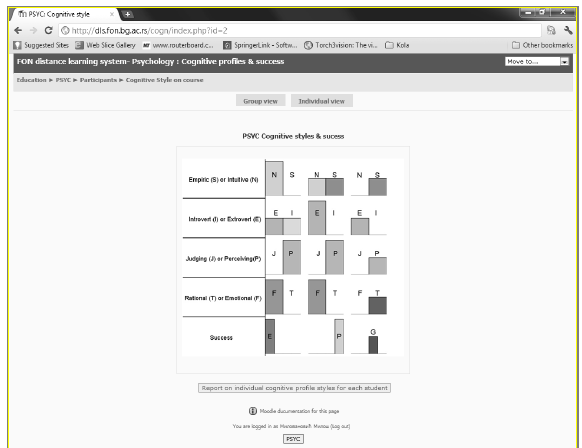
Fig. 9. Moodle report for description of students’ cognitive style and the success they had on the course Educator can then go further in analysis and track each student according to its expected success based on cognitive style. Educator can change his approach to